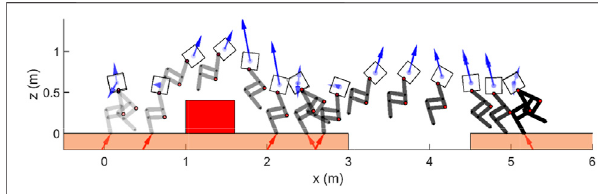
FIGURE 7 | An overview of Harpy ’ s controller